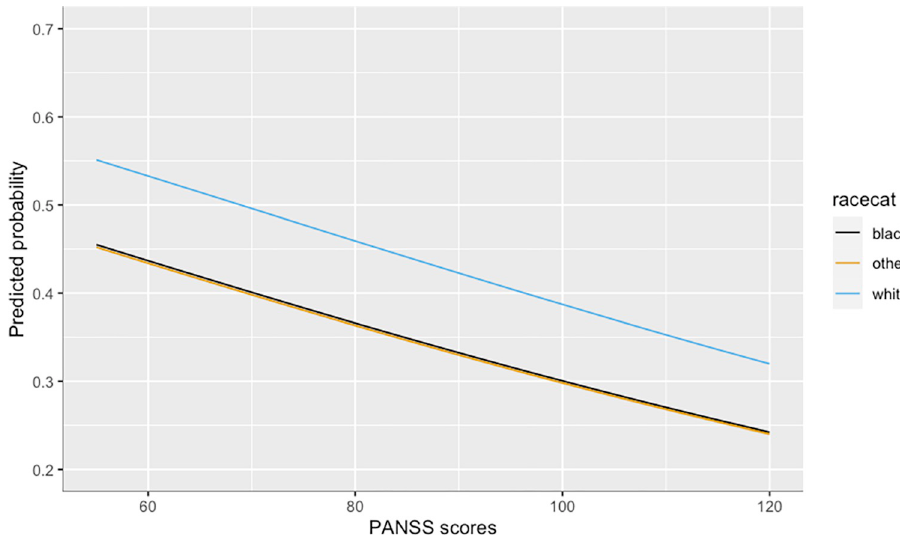
Fig 1. Predicted probabilities of genetic study participation from the logit model. Y-axis indicates probabilities and x-axis indicates psychopathology symptom scores measured by PANSS. At any level of psychopathology symptoms, Black and Other participants were less likely to participate in the genetic study compared to White